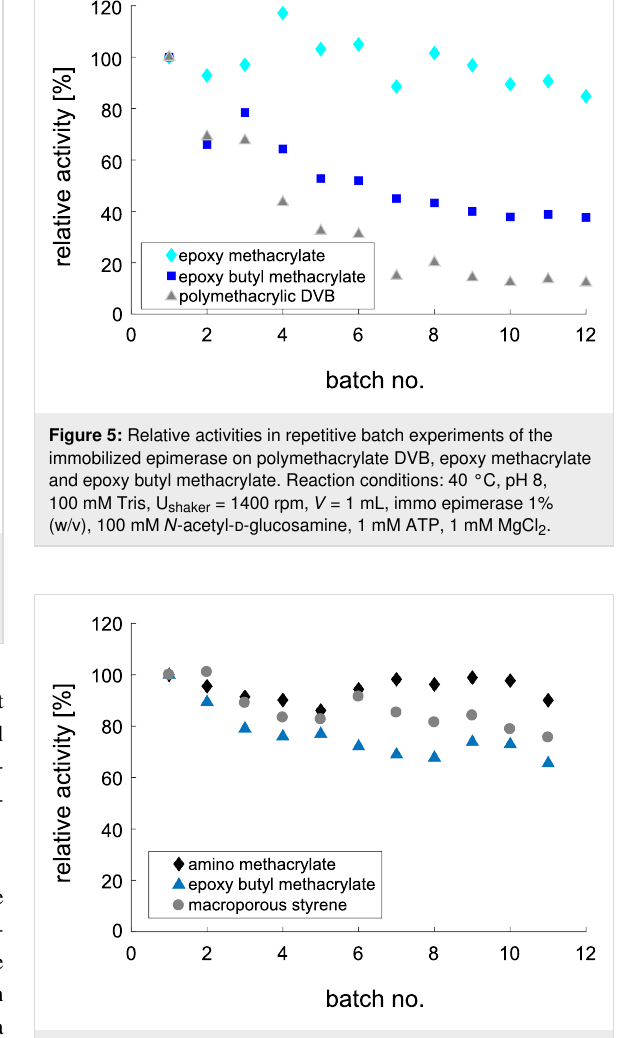
Figure 6: Relative activities in repetitive batch experiments of the immobilized aldolase on amino methacrylate, epoxy butyl methacry- late, and macroporous styrene. Reaction conditions: 40 °C, pH 8, 100 mM Tris, U shaker = 1400 rpm, V = 1 mL, immo aldolase 5% (w/v), 100 mM N -acetyl- ᴅ -mannosamine, 250 mM